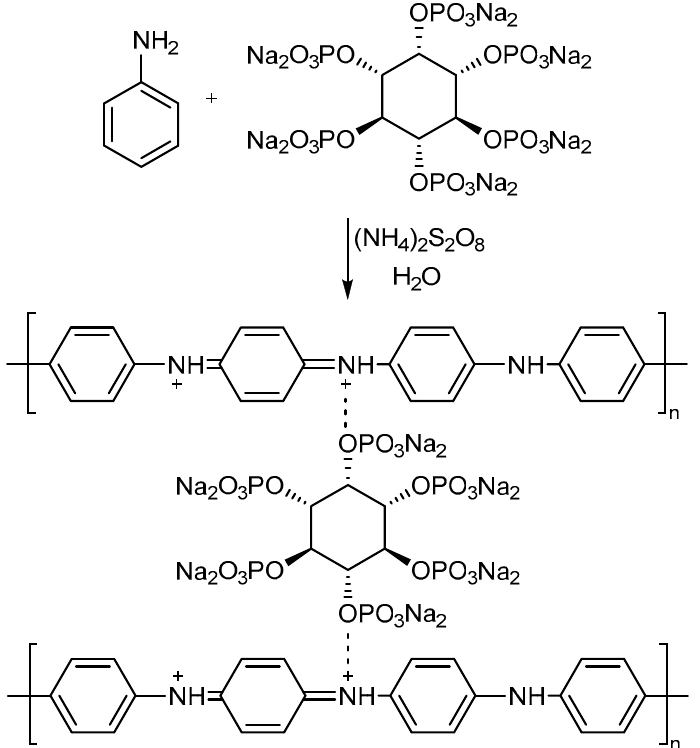
Scheme 1. Synthesis mechanism of sodium phytate doped polyaniline (PANI).